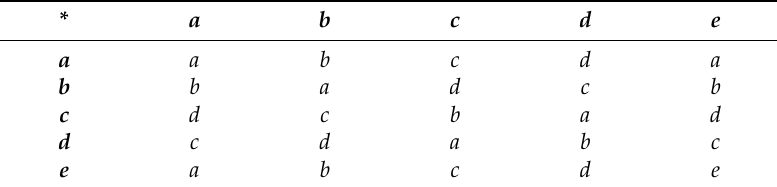
Table 4. The operation * on N